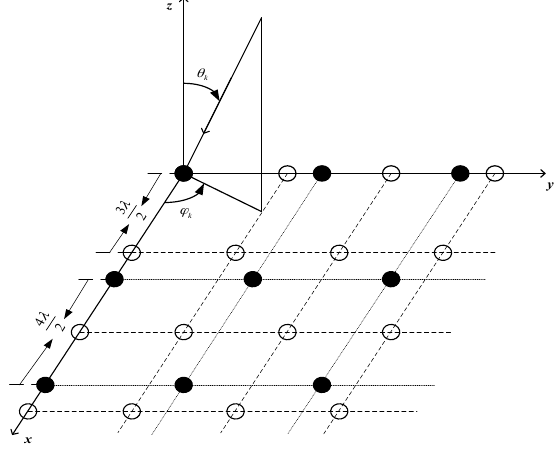
Figure 1. Geometry of coprime planar array when M 1 = 3, M 2 = 4.